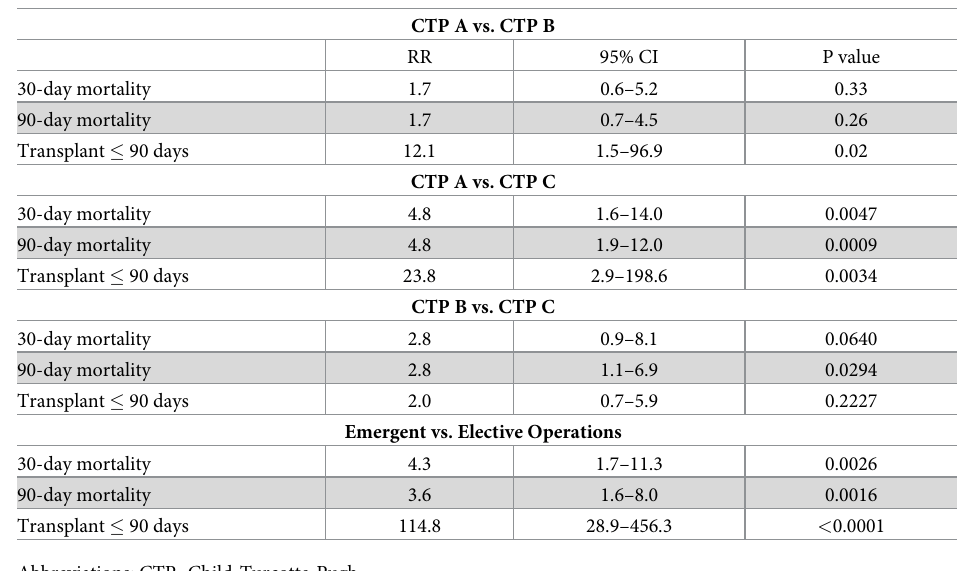
Table 4. Relative